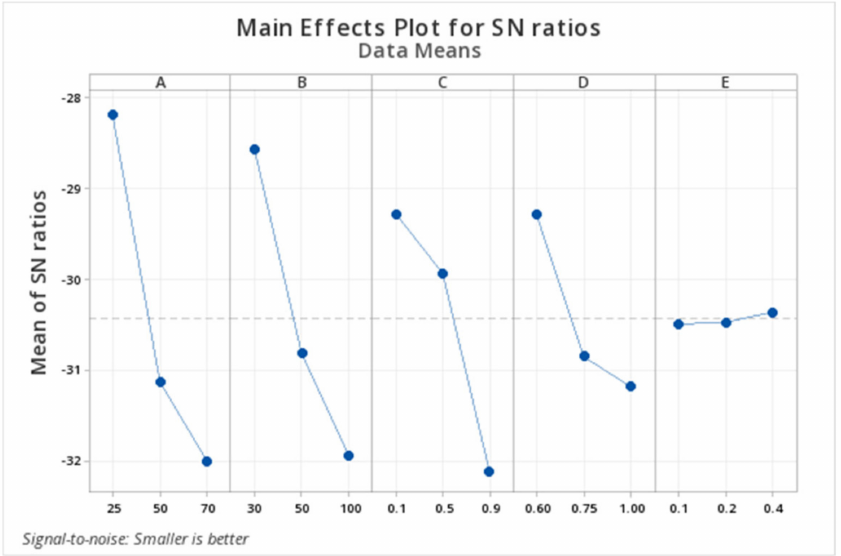
Figure 7. Main effects plot for SN ratio of